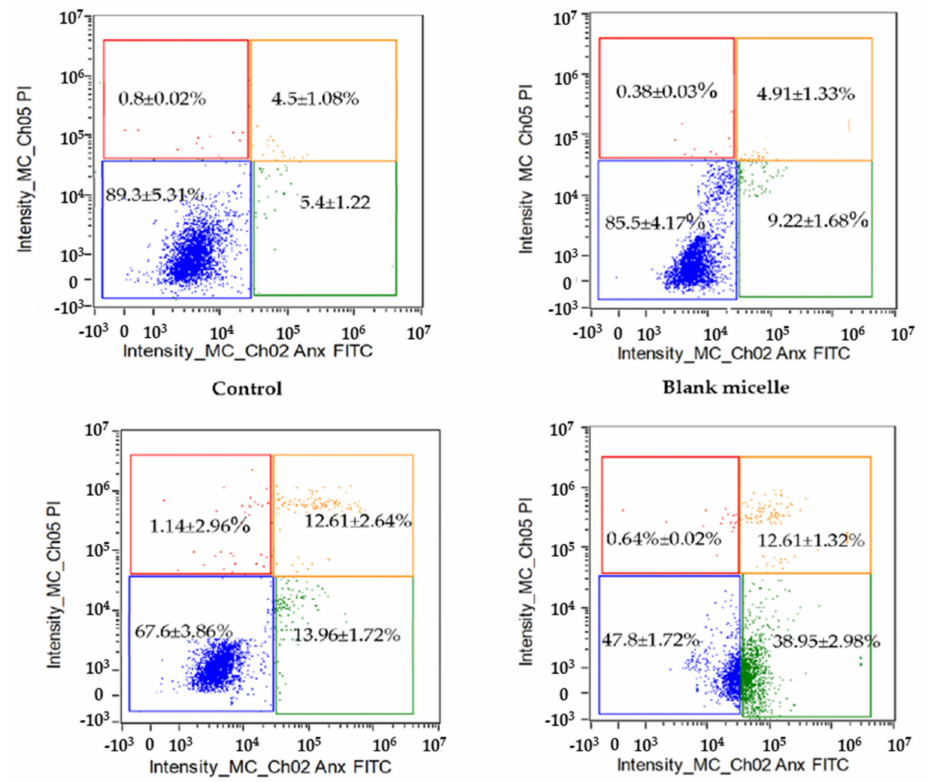
Figure 10. The effect of curcumin analog (CL) and CL-loaded NBSCh micelles on induced apoptosis of HT-29 human colon cancer cells. Lower left quadrant represents viable cells that do not bind to AnnexinV-FitC or PI; lower right quadrant represent early apoptotic cells binding to only AnnexinV- FitC; top right quadrant represent necrotic or late apoptotic cells that were both AnnexinV-FitC- and PI-positive; and top left quadrant represent necrotic cells binding to only